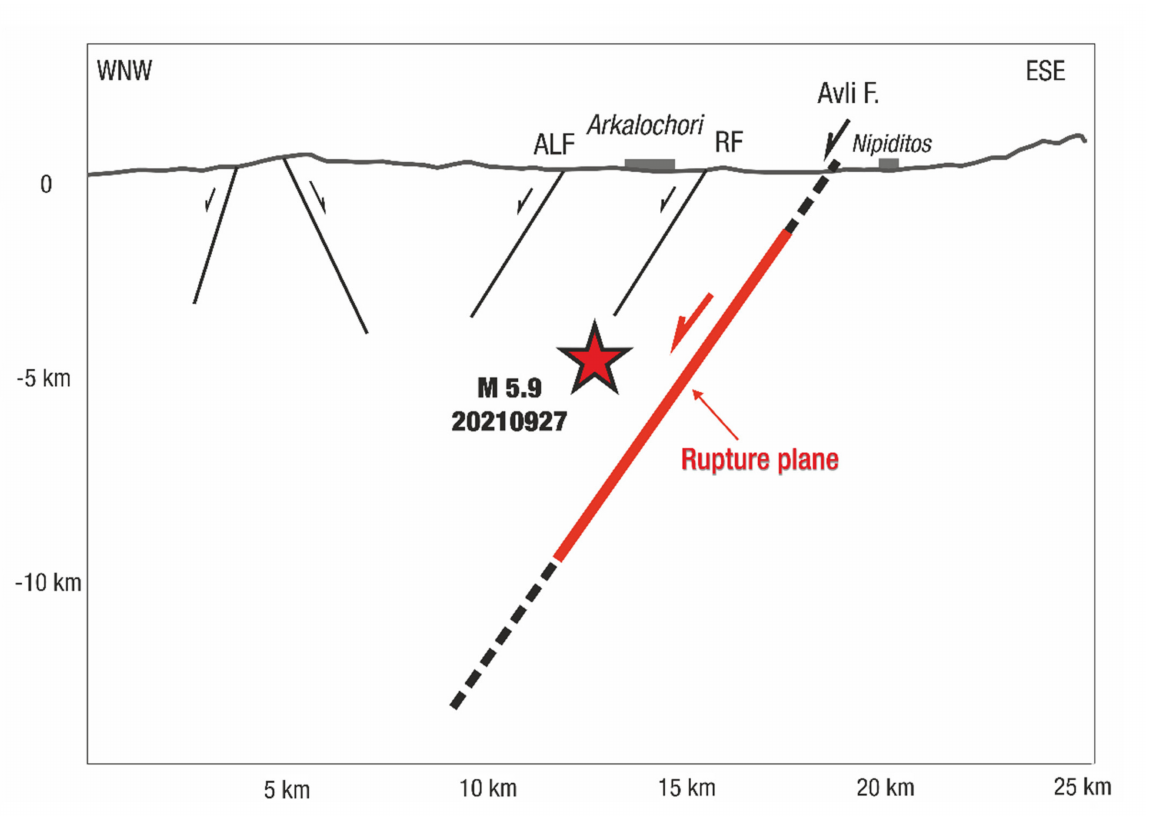
Figure 14. Cross-section (heading N110 ◦ E) showing the projected seismic fault of the Arkalochori earthquake of 27 September 2021. The surface projection of the fault plane meets the trace of the neotectonic Avli Fault. Topography is shown with grey line and red arrow indicates sense of displacement, respectively. Other minor normal faults (ALF, RF) are also shown. See Figure 1 for profile